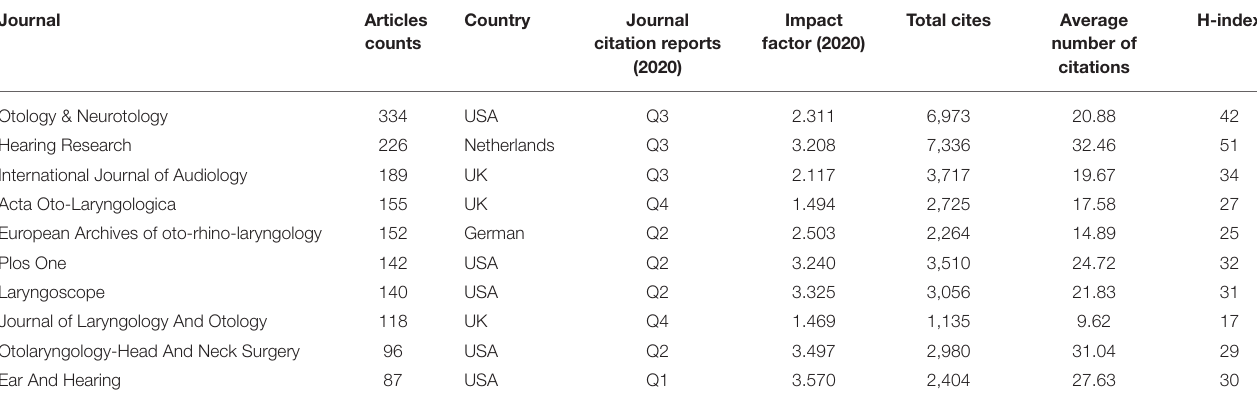
TABLE 4 | Ranking of top 10 journals for number of published articles on tinnitus research from 2001 to